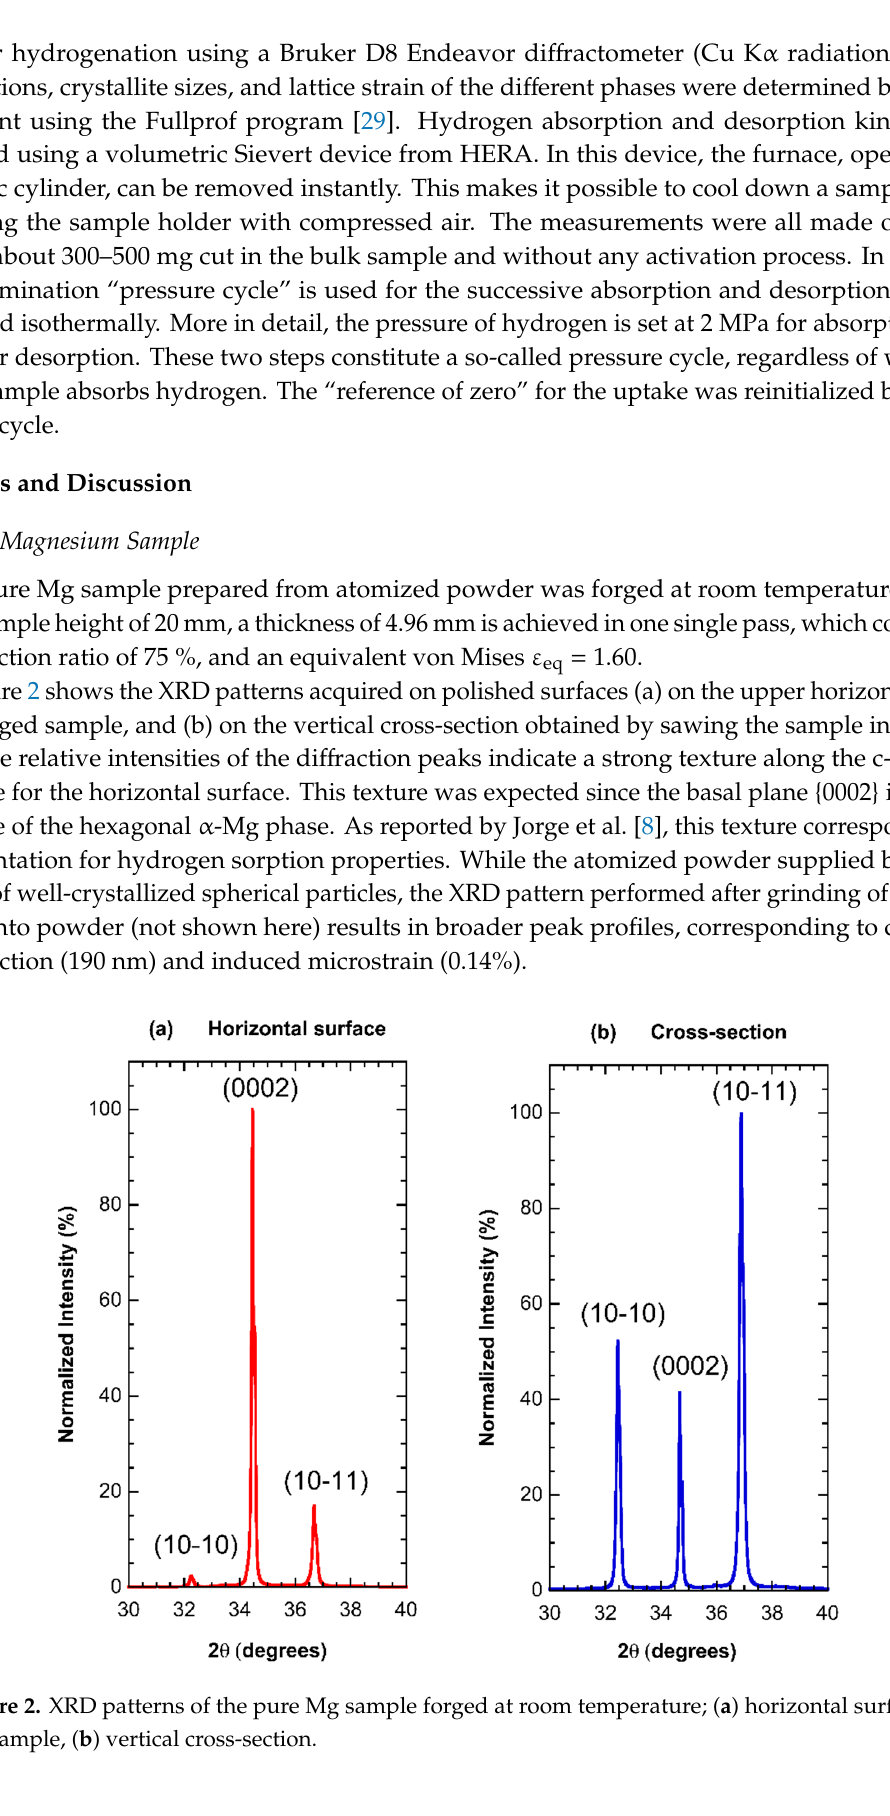
Figure 1. ( a ) Internal part of the forging chamber, with a sample into the high-frequency heating coil; ( b ) pure magnesium sample forged at room temperature.